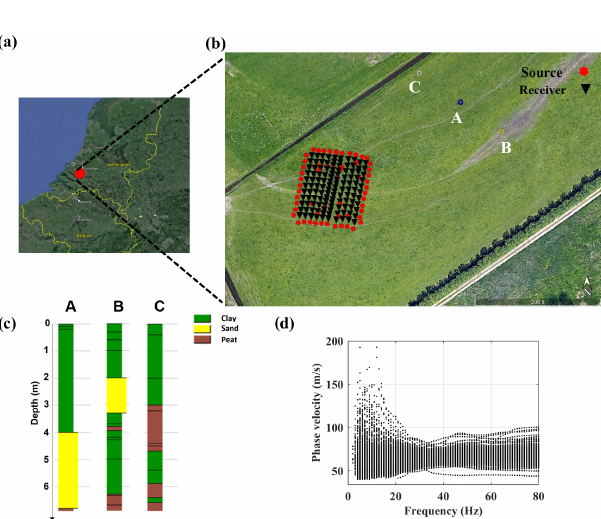
Figure 8. (a) Aerial view of the Netherlands with the red cir- cle marking the location of the Pijancker field (©Google Earth). (b) The acquisition geometry (©Google Earth), (c) the available well data near the field. The location of each well is shown with the corresponding letter in subfigure (b) . (d) The retrieved